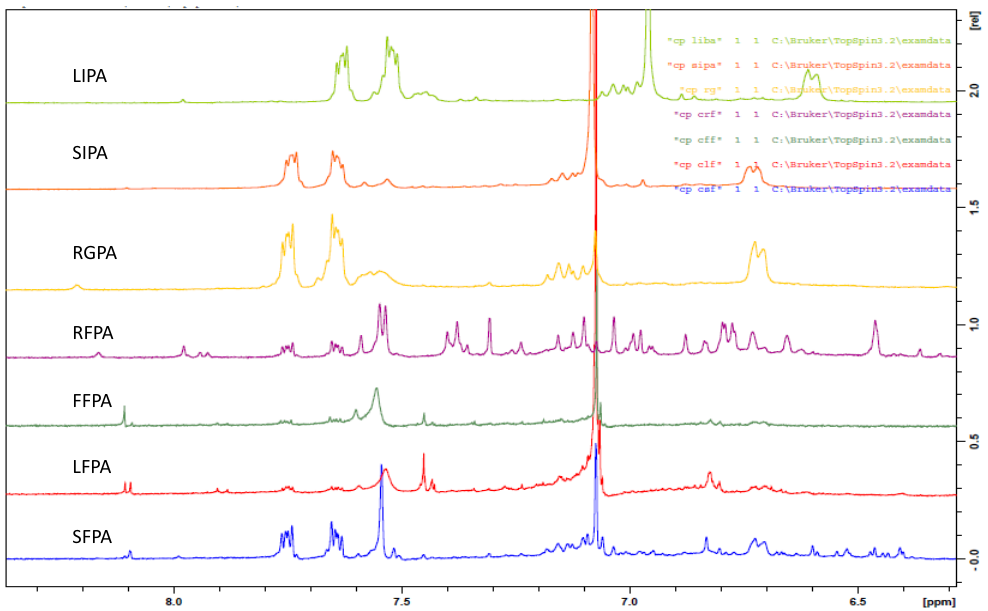
Figure 6. The 1 H-NMR spectra indicating the chemical shift ( δ ppm) of the phenolic acid extracts at the Figure 6. The 1 H NMR spectra indicating the chemical shift (δ ppm) of the phenolic acid extracts at aromatic the aromatic region.